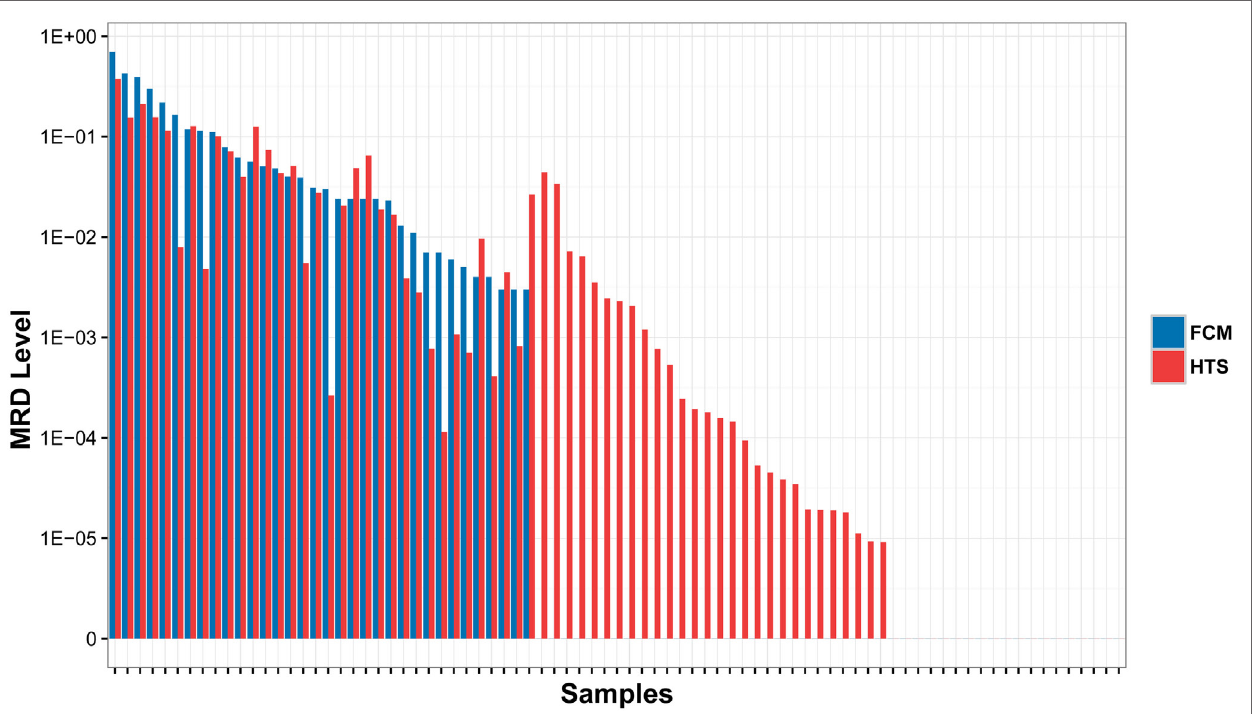
FigUre 2 | comparison of MrD results detected by high throughput sequencing (hTs) with flow cytometry (FcM) assays . The samples were classified into three subsets: (1) MRD was detected positive by both HTS and FCM (left); (2) MRD were detected positive by HTS, but negative by FCM (middle); and (3) MRD was detected negative by both methods